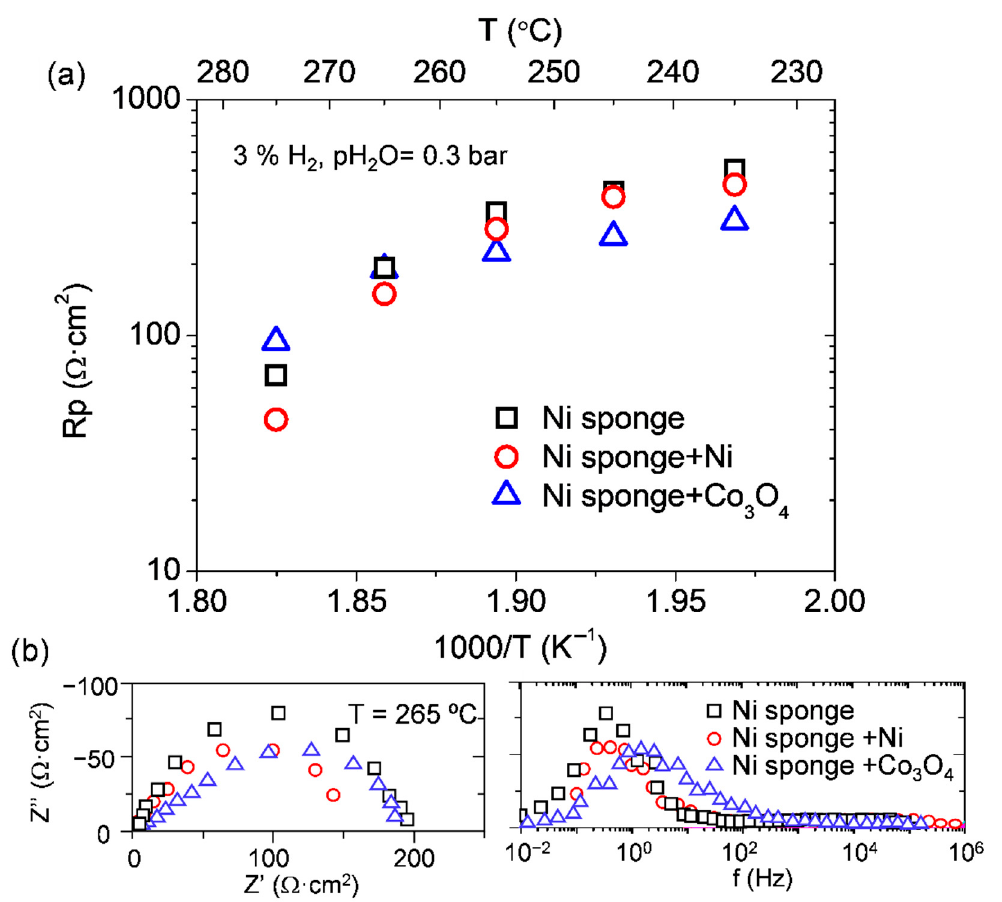
Figure 8. ( a ) Polarization resistance of the three different electrodes: Ni sponge, Ni sponge + Ni, and Ni sponge and Co 3 O 4 electrodes as function of temperature. ( b ) Nyquist’s and Bode’s plot of electrodes at 265 °C.